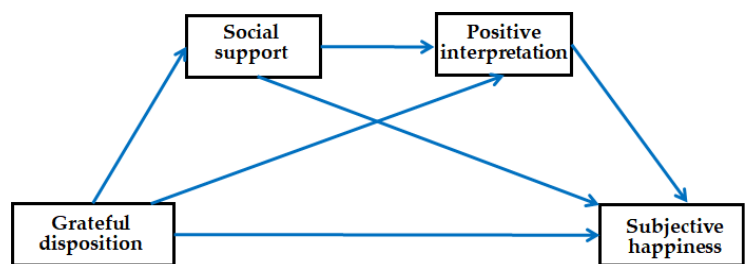
Figure 1. Double sequential mediation model.